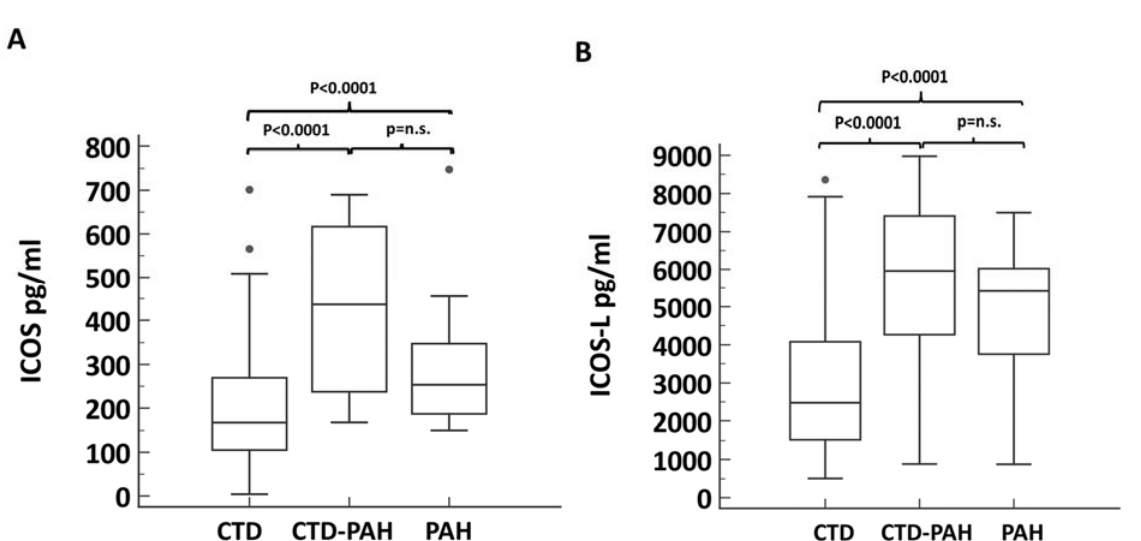
Figure 1. Comparison of ICOS and ICOS-L between patients affected by CTD, with and without PAH. In ( A ) the plasma concentration of ICOS is compared between groups; ( B ) conversely reports the comparison of ICOS-L plasma concentrations. Abbreviations: CTD = connective tissue disease and PAH = pulmonary arterial hypertension.